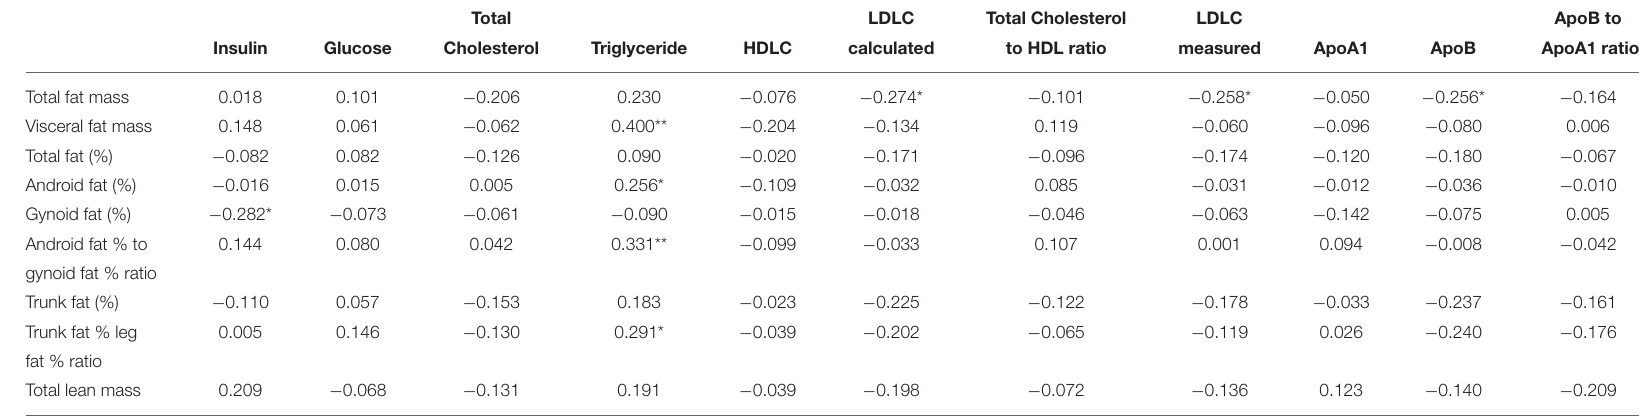
TABLE 6 | Spearman’s correlations between changes in body composition measures due to intervention with changes in blood markers of cardiometabolic health in women ( N = 66).